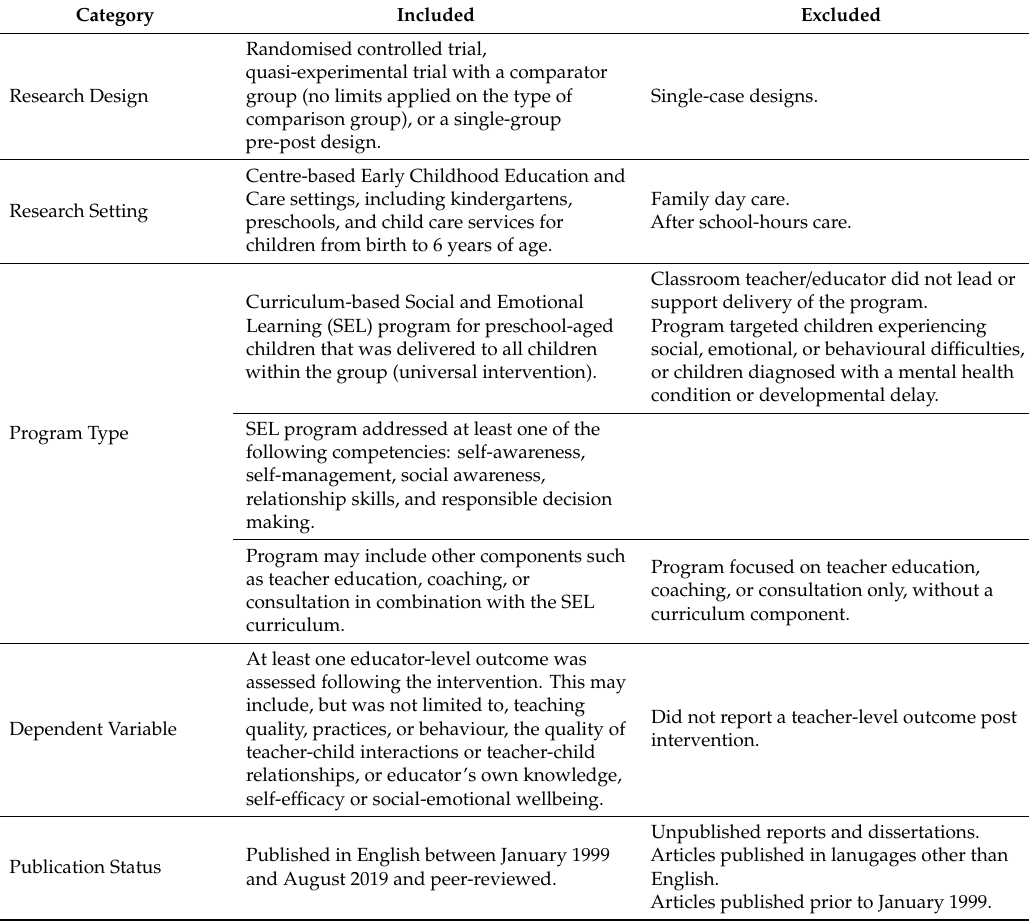
Table 2. Inclusion and Exclusion